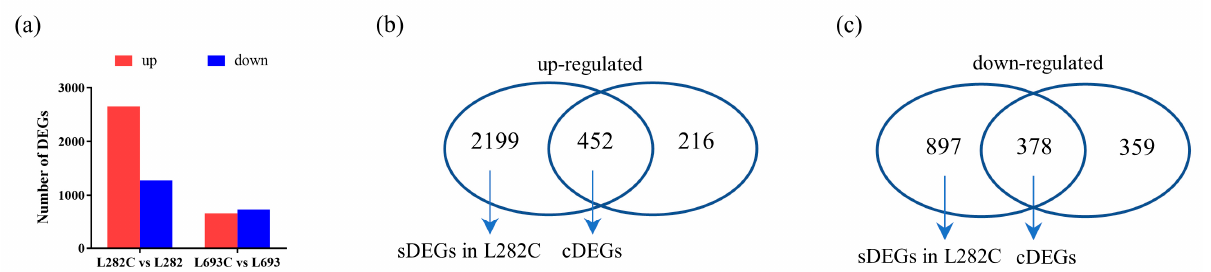
Figure 3. DEG analysis of L282 and L693 seeds germinated at normal and cold temperatures. ( a ) The numbers of upregulated and downregulated DEGs between L282C (L282 cold germination) and L282 (L282 normal germination) and those between L693C and L693; the common upregulated ( b ) and downregulated ( c ) DEGs (cDEGs) in both lines, and specially expressed DEGs (sDEGs) in L282C.